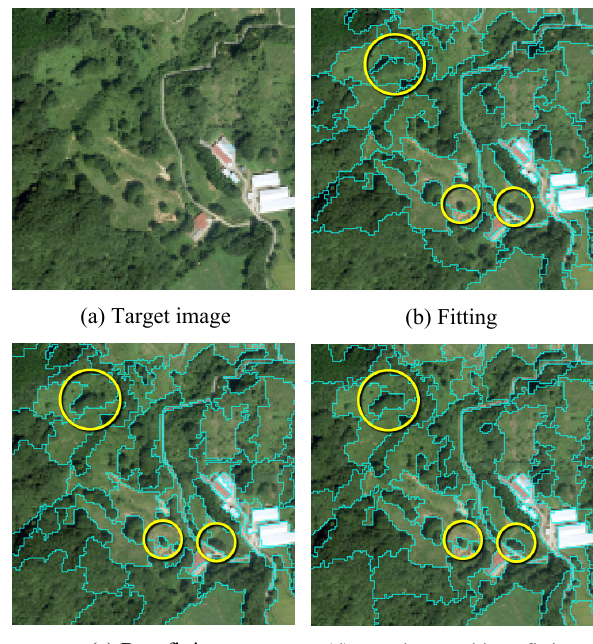
Figure 1. Application results based on different rules of merging objects